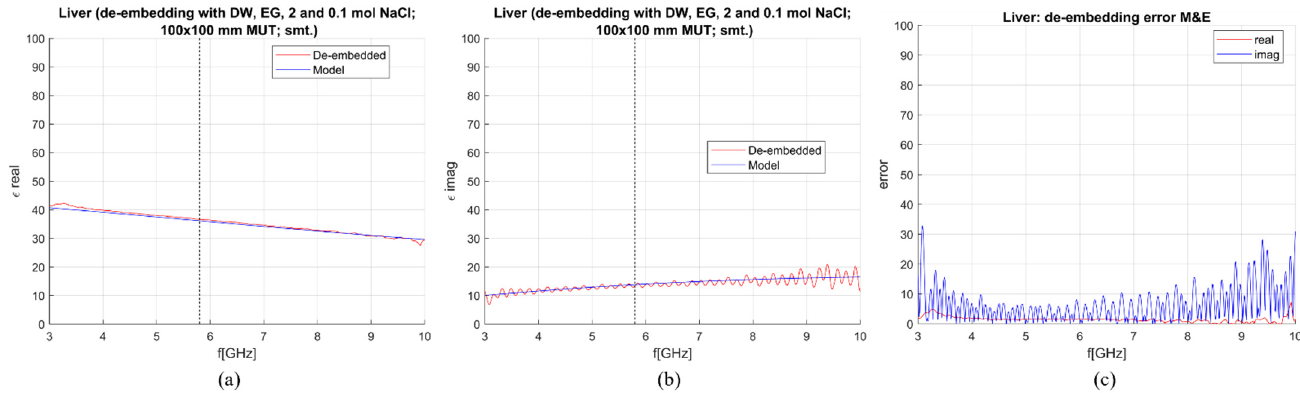
(de-embedding error) for ε ’ (“real”) and ε ’’ (“imag”).